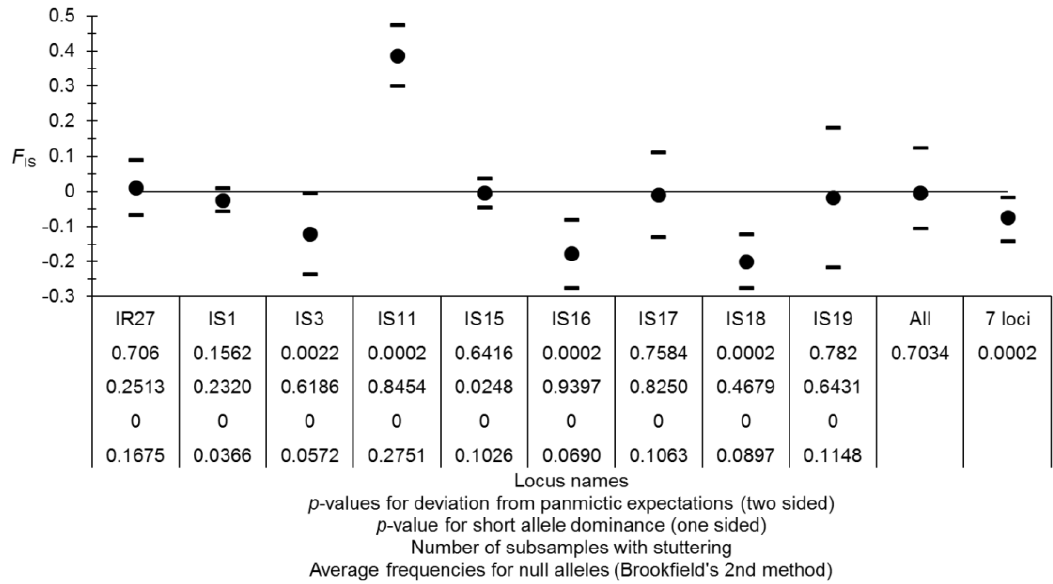
Figure 5. F IS values for each locus, averaged across those (All), or over 7 loci without amplification problems (IS11 and IS15) for Ixodes scapularis cured data from the eastern U.S.A. with 95% jackknife confidence intervals over subsamples (for each locus) and bootstraps over loci (All). Results of tests for panmixia, short allele dominance, number of subsamples with stuttering for each locus, and null allele frequencies are also